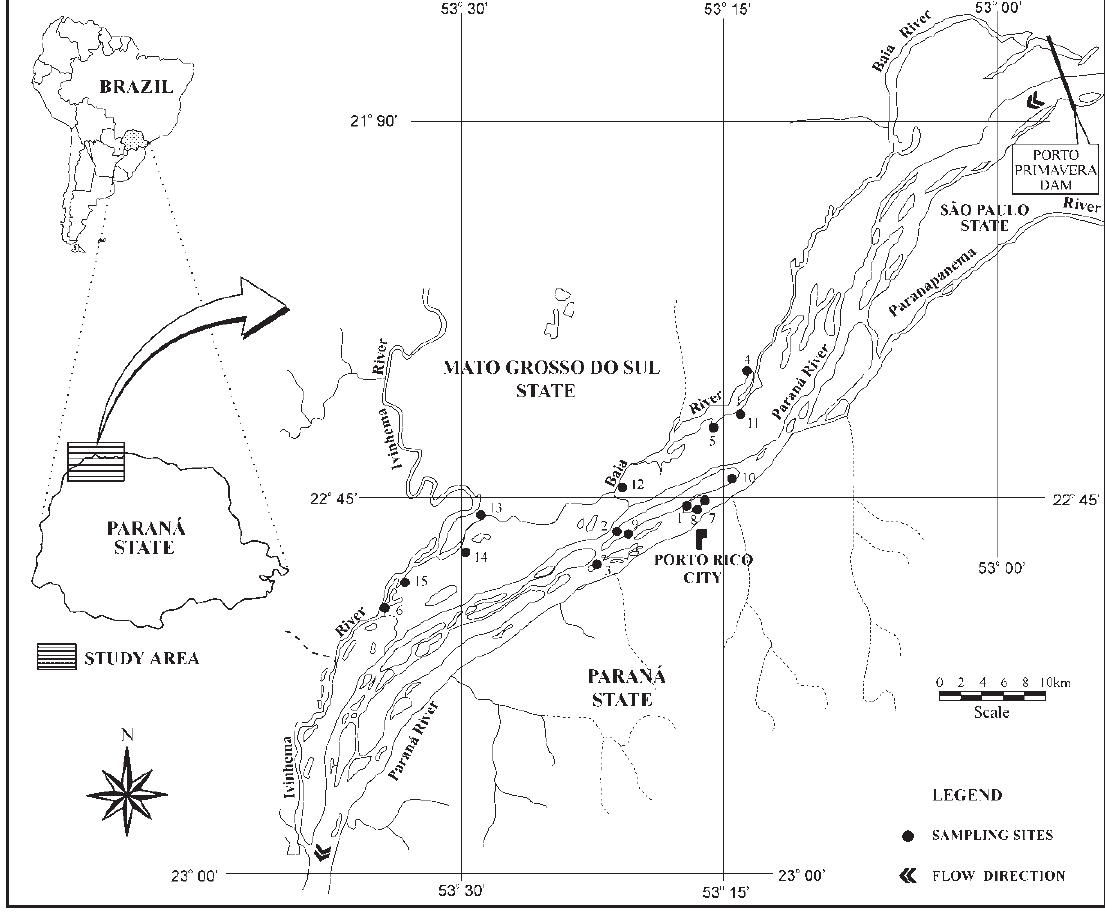
Fig. 1. Study area with location of sampling sites in connected (1-6) and disconnected lagoons (7-15): 1 (Leopoldo), 2 (Manezinho), 3 (Pombas), 4 (Maria Luíza), 5 (Porcos), 6 (Ipoitã), 7 (Clara), 8 (Genipapo), 9 (Osmar), 10 (Pousada), 11 (Aurélio), 12 (Traíra), 13 (Cervo), 14 (Jacaré), 15